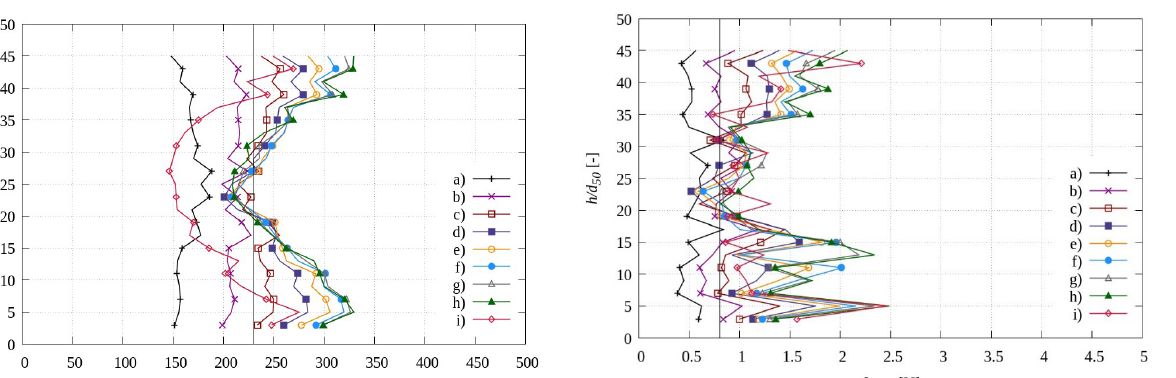
Figure 26: Distribution of the normal forces f across the normalized specimen height h / d for: a) u = 0.25 mm, b) u x mm, e) u = 1.25 mm, f) u x mm and i) u = 10.00 mm ( e x (dark vertical line demonstrates 5% limit).